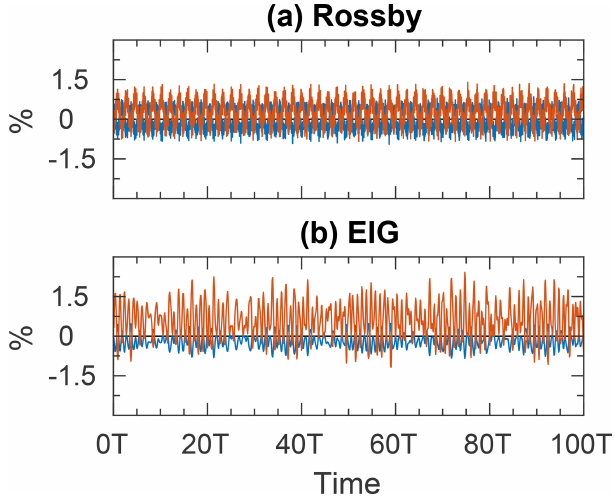
Figure 9. Same as Fig. 6, but for the perturbed Rossby (a) and EIG (b)